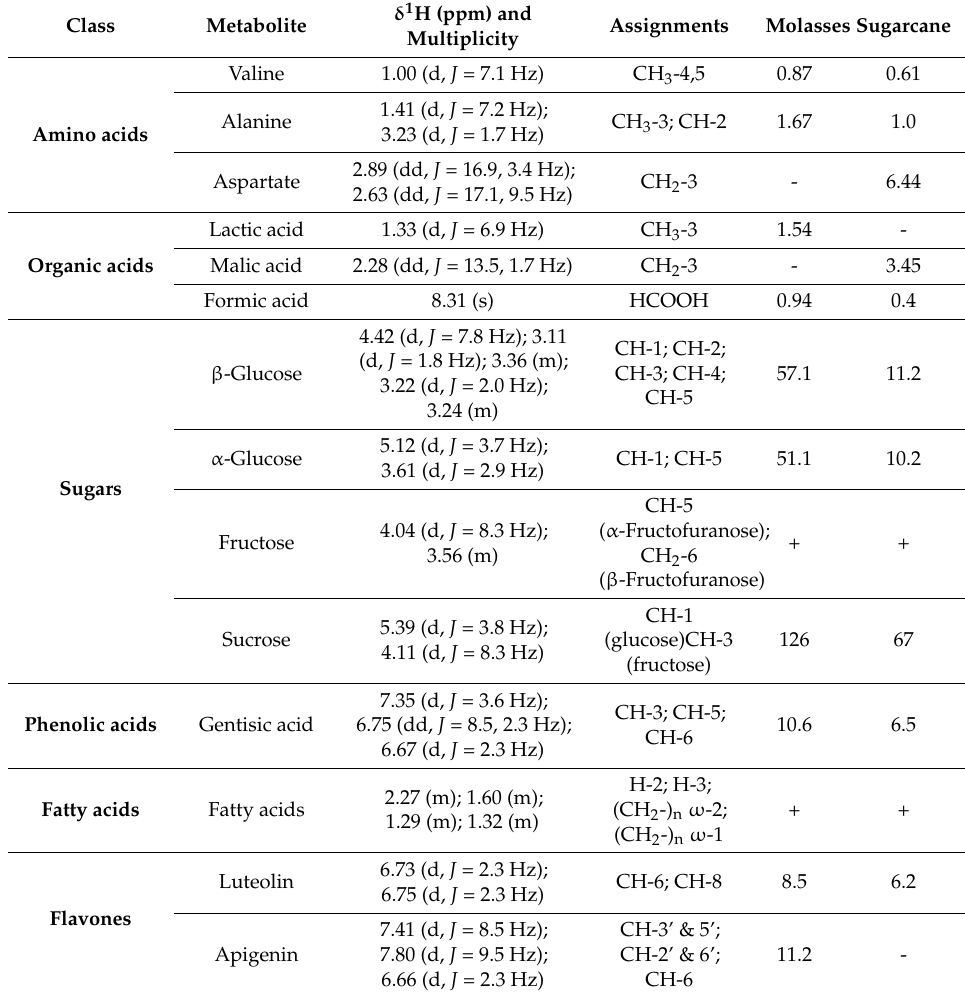
Table 1. Resonance assignments with chemical shifts of constituents identified molasses and